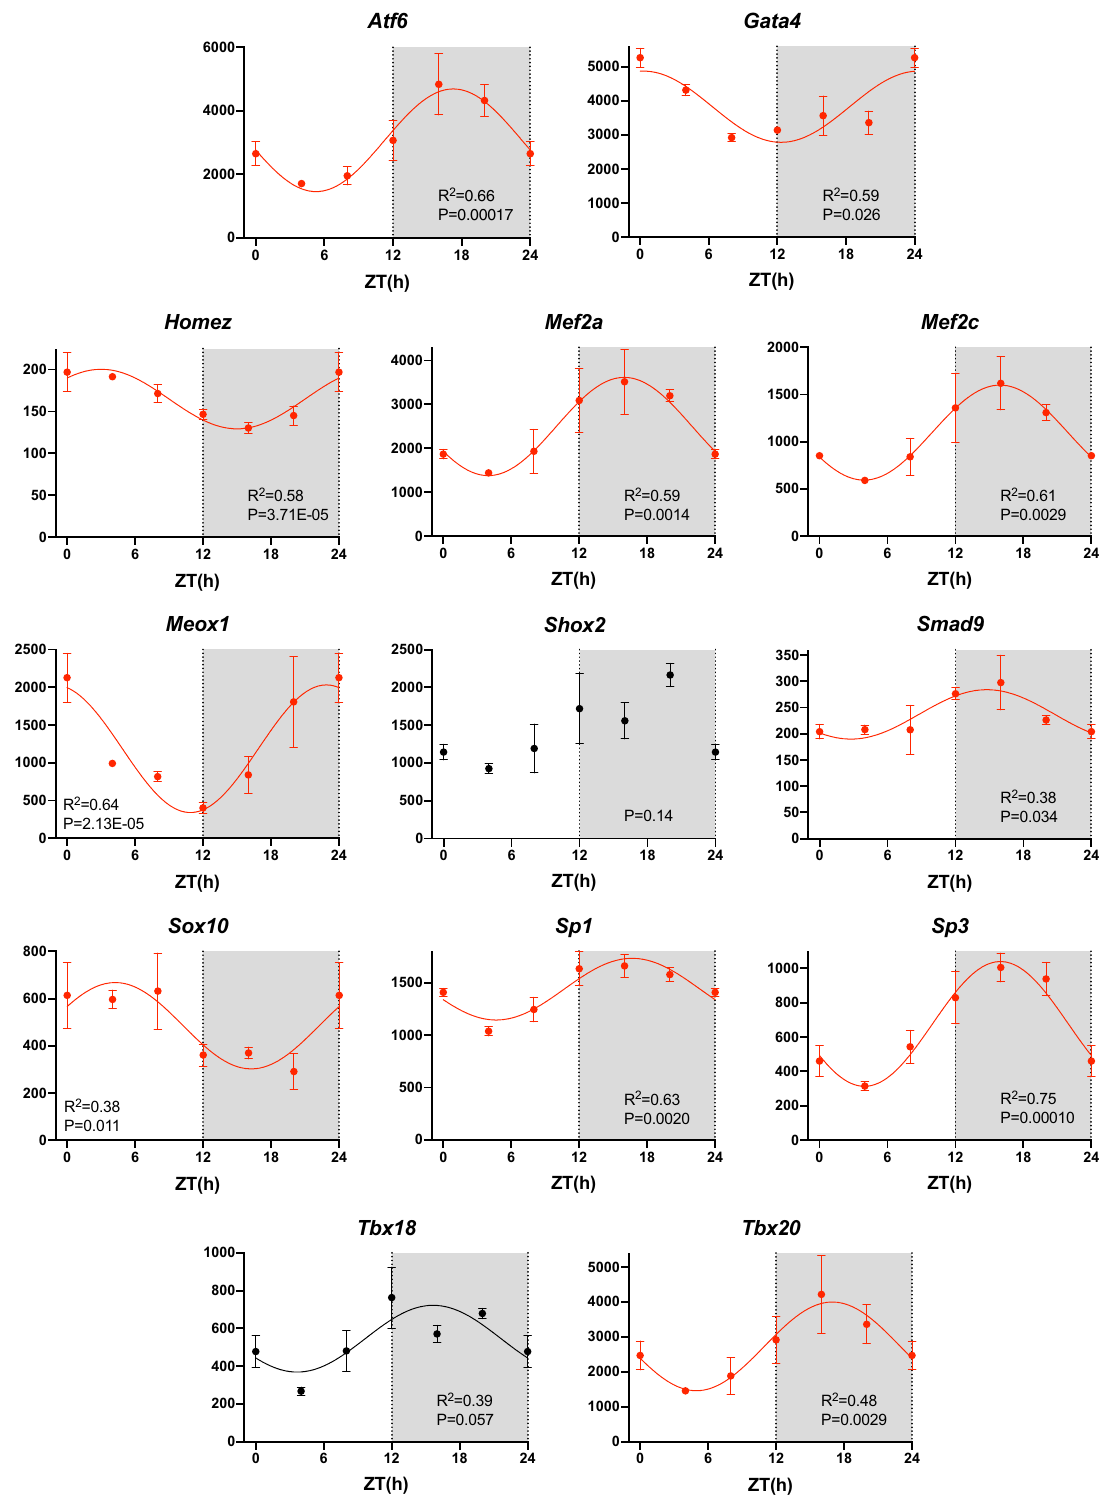
Figure 8. Transcription Factors. Abundance (normalised counts) of example transcription factor transcripts is shown over 24 h. See Fig. 1 legend for further